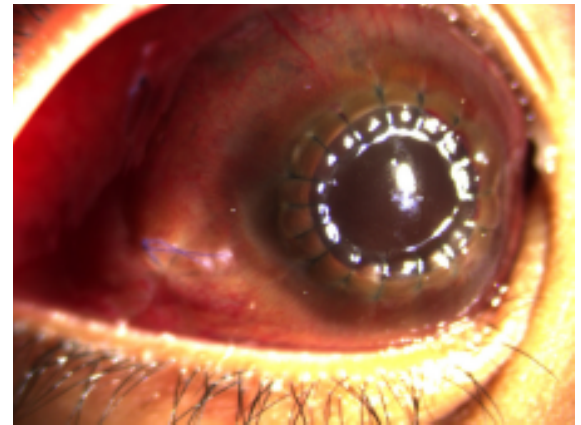
Figure 3: Third-week postoperative slitlamp examination of the right eye